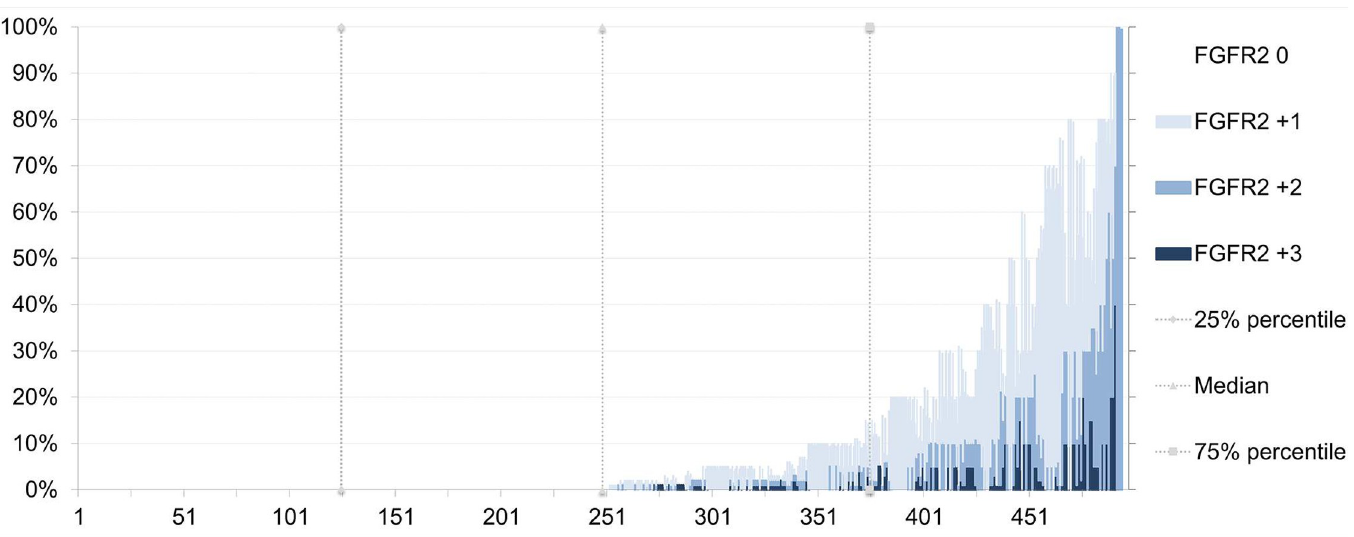
Fig 2. Distribution of FGFR2 protein expression in the cohort. FGFR2 staining was detected in 245 (49.1%) of the cases examined. Overall, there was a heterogeneous combination of different intensities of FGFR2 immunostaining. The occurrence of all staining intensities, i.e., FGFR-IHC 0/1 + /2 + and 3 + was observed in 73 cases (14.8%). Staining of large tumor fractions was observed rather rarely. Only 39 cases (7.9%) showed staining of more than 50% of the tumor